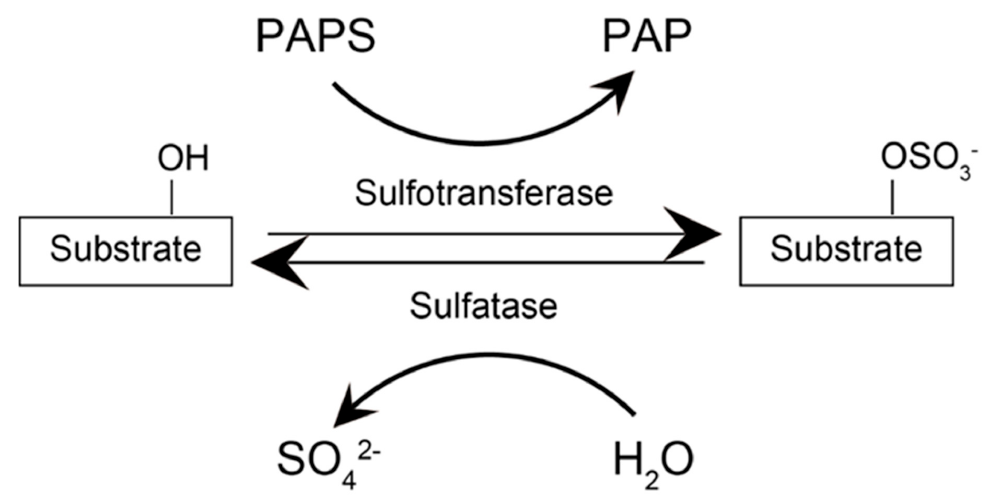
Figure 1. Sulfatase and sulfotransferase. Sulfotransferase transfers a sulfate at the expense of PAPS at the specific position of lipids, cholesterol, and sugars. Sulfatase removes a sulfate from the substrate. Sulfatase needs to be activated by a formylglycine-generating enzyme, as described in the text. PAPS, 3 ′ -phosphoadenosine 5 ′ -phosphosulfate. Table 1. Sulfatases in humans and